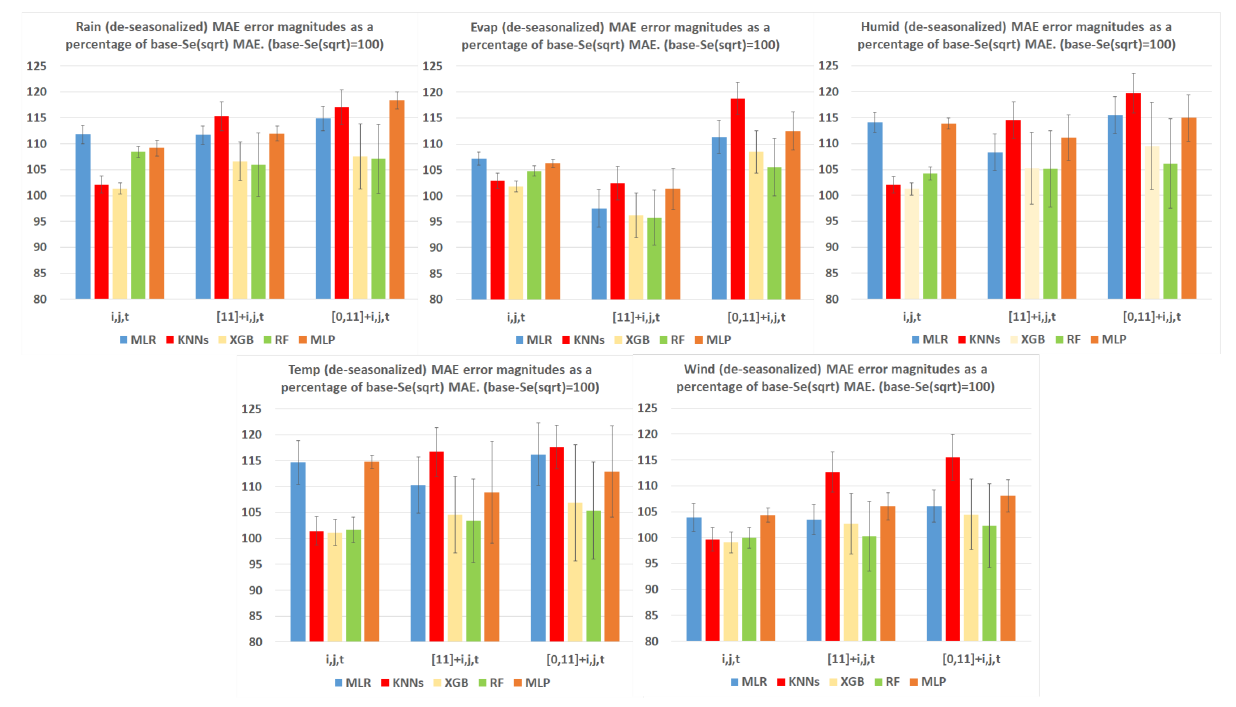
Figure 13. MAE of all trained models with features [i,j,t, i,j,t+[11], i,j,t+[0,11]], compared to base-Se(sqrt) on the de- seasonalized climate datasets. On the vertical scales, 100 corresponds to the MAE for the base-Se(sqrt)